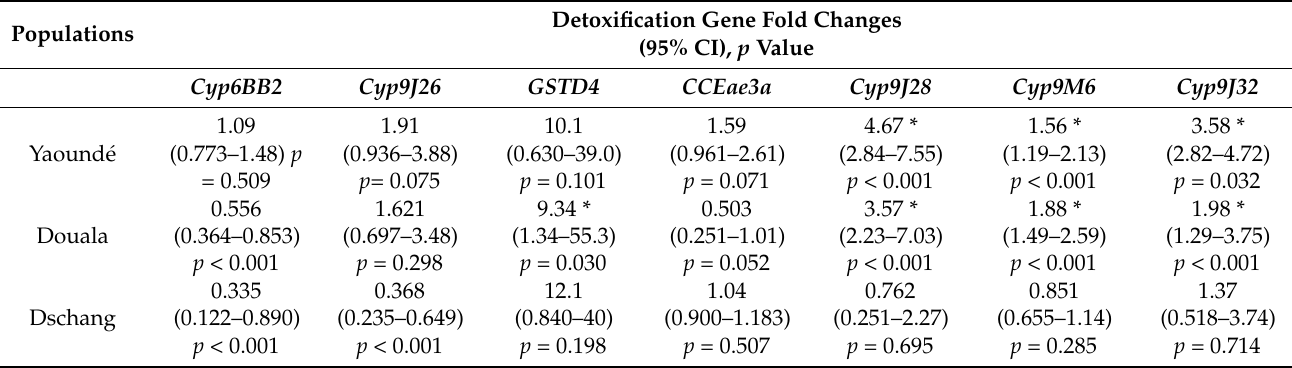
Table 4. Expression analysis of the detoxification genes analyzed in the three resistant Aedes aegypti mosquito populations compared to the susceptible mosquito